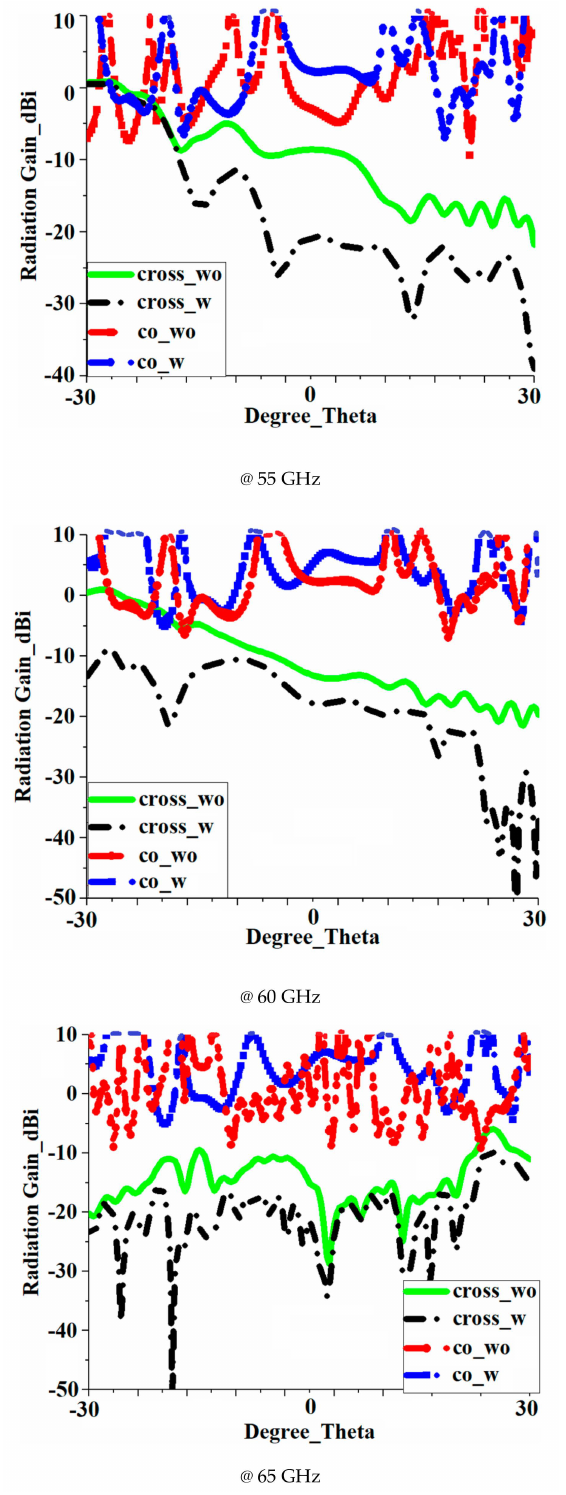
Figure 6. Co- and cross-polarized radiation gain patterns of the proposed structure without (WO) and with (W)